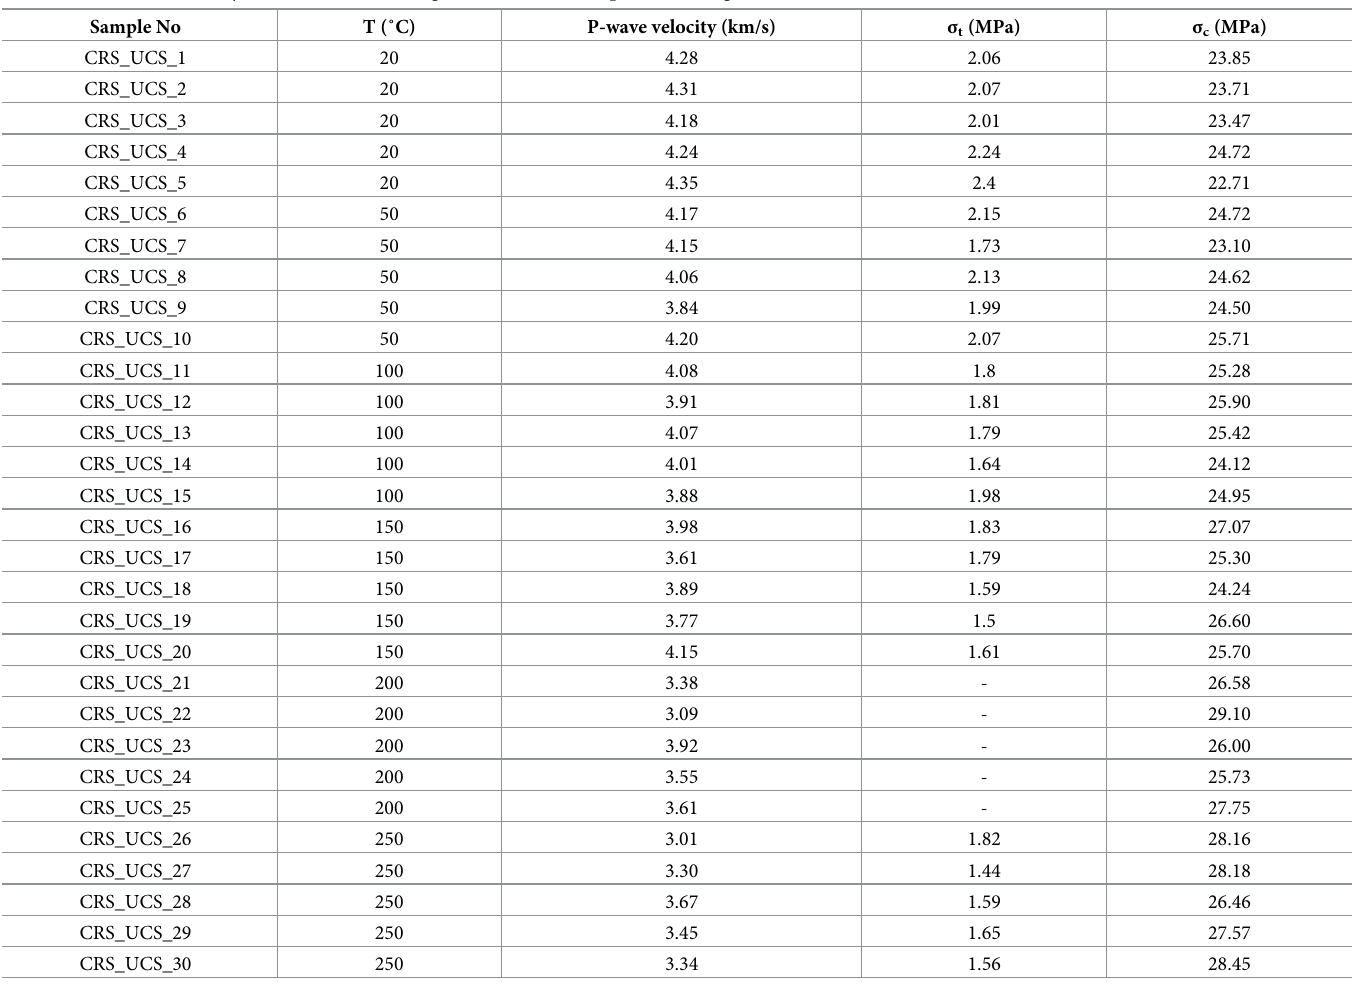
Table 1. The P-wave velocity, Brazilian tensile strength, and uniaxial compressive strength test results of the rock salt. Sample No